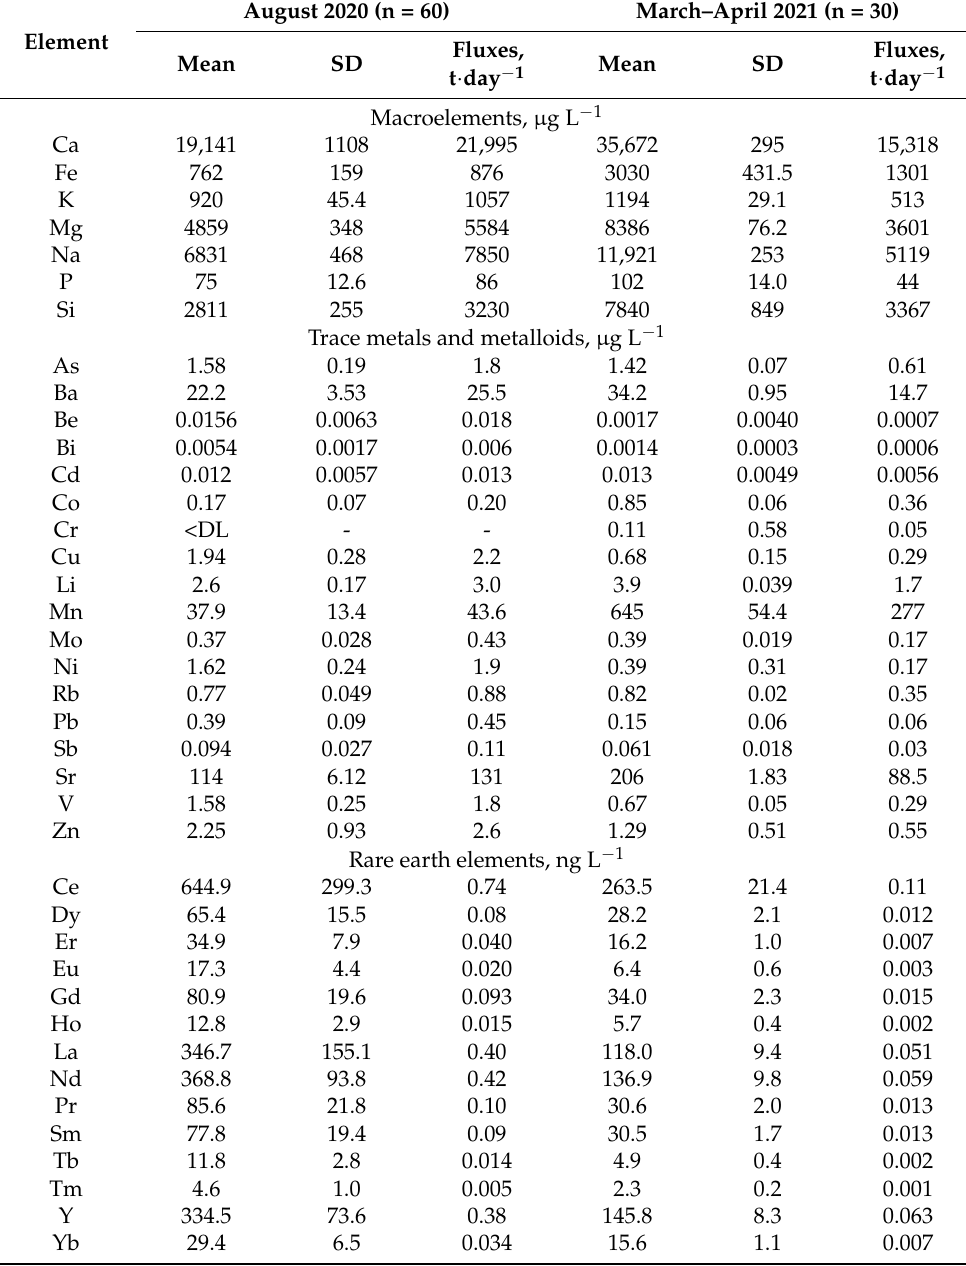
Table 2. Elemental composition of Ob River water and element flux (unfiltered samples).